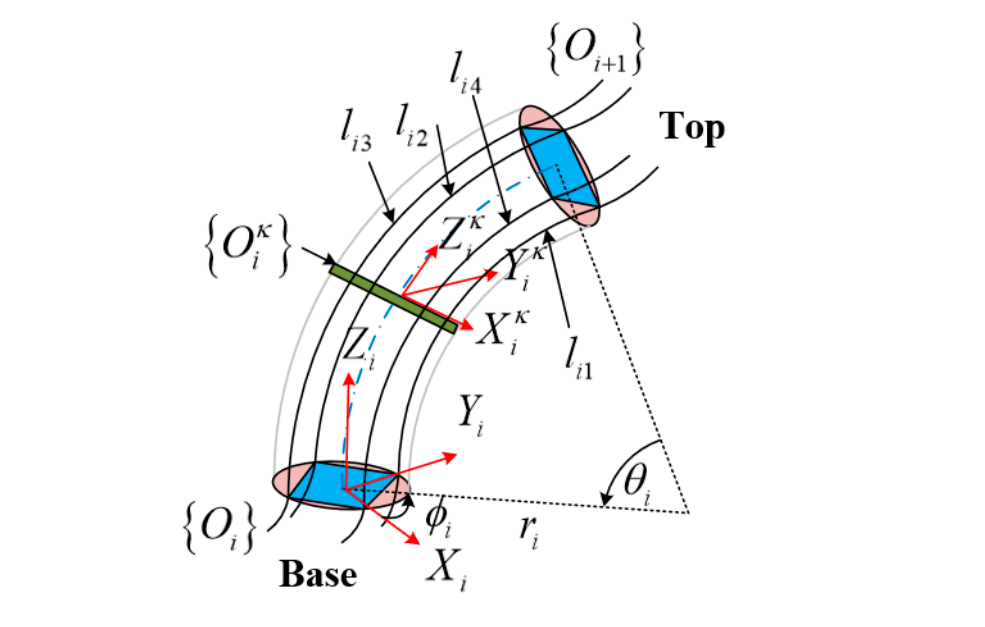
Figure 2. Deformation mode of a single continuum node. A schematic diagram of a single continuum node bending at deflection angle φ i is provided in Figure 3a, while the top view of the continuum node is shown in Figure 3b. Separate reference coordinate systems are established for the bottom and top. From the geometry of the figure, the radius of curvature measured from the center of the continuum node is related to the radius of curvature of each PMA. In the case of PMA1, the geometric relationship between r i and r 1 is presented as: